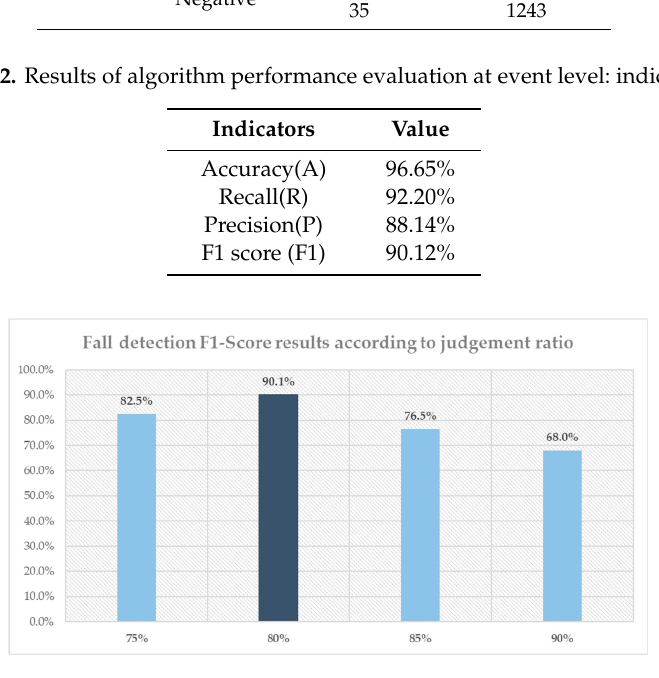
Table 11. Results of algorithm performance evaluation at event level: raw data.